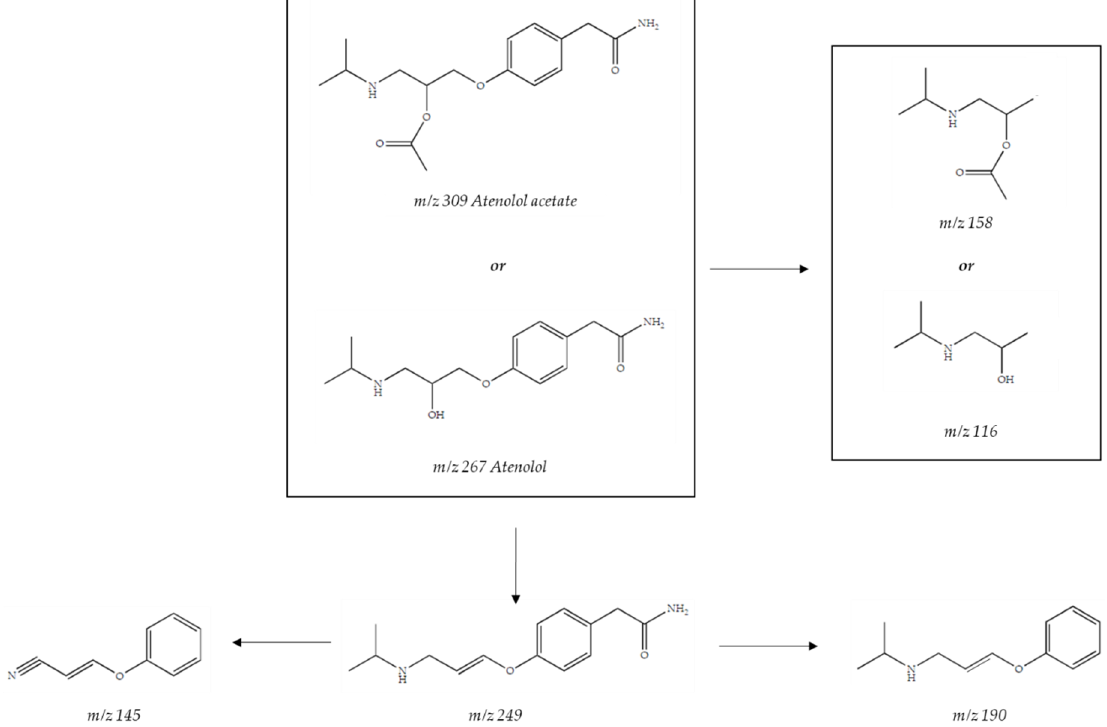
Figure 6. Fragmentation pathways for molecular ions of atenolol.